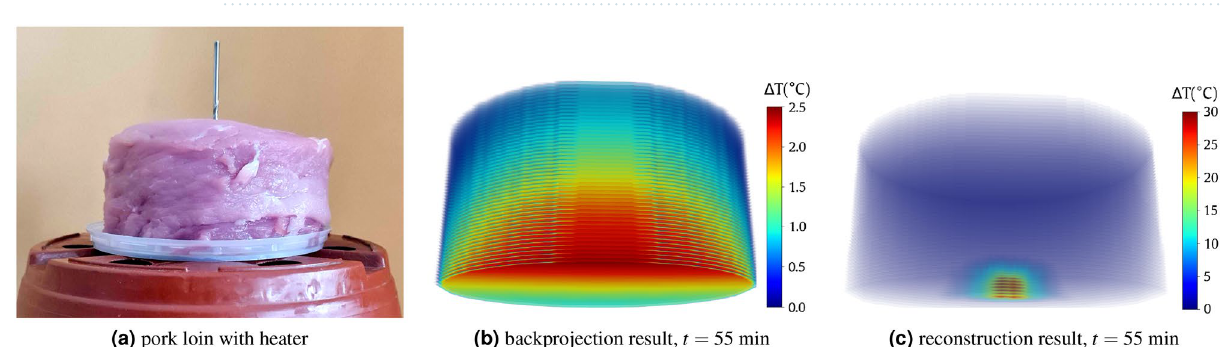
Figure 7. Model evaluation (experiment #2): the cylindrical pork object ( a ), backprojection ( b ) and reconstruction results ( c